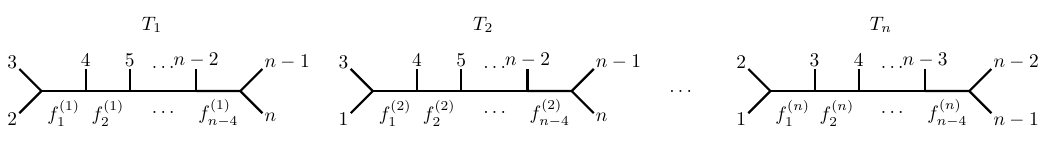
Figure 3 . This graph is sometimes called a “caterpillar” tree. Leaves 1 and n are usually called the head and tail but we call the sets { 1 , 2 } and { n − 1 , n } the cherries of the tree.